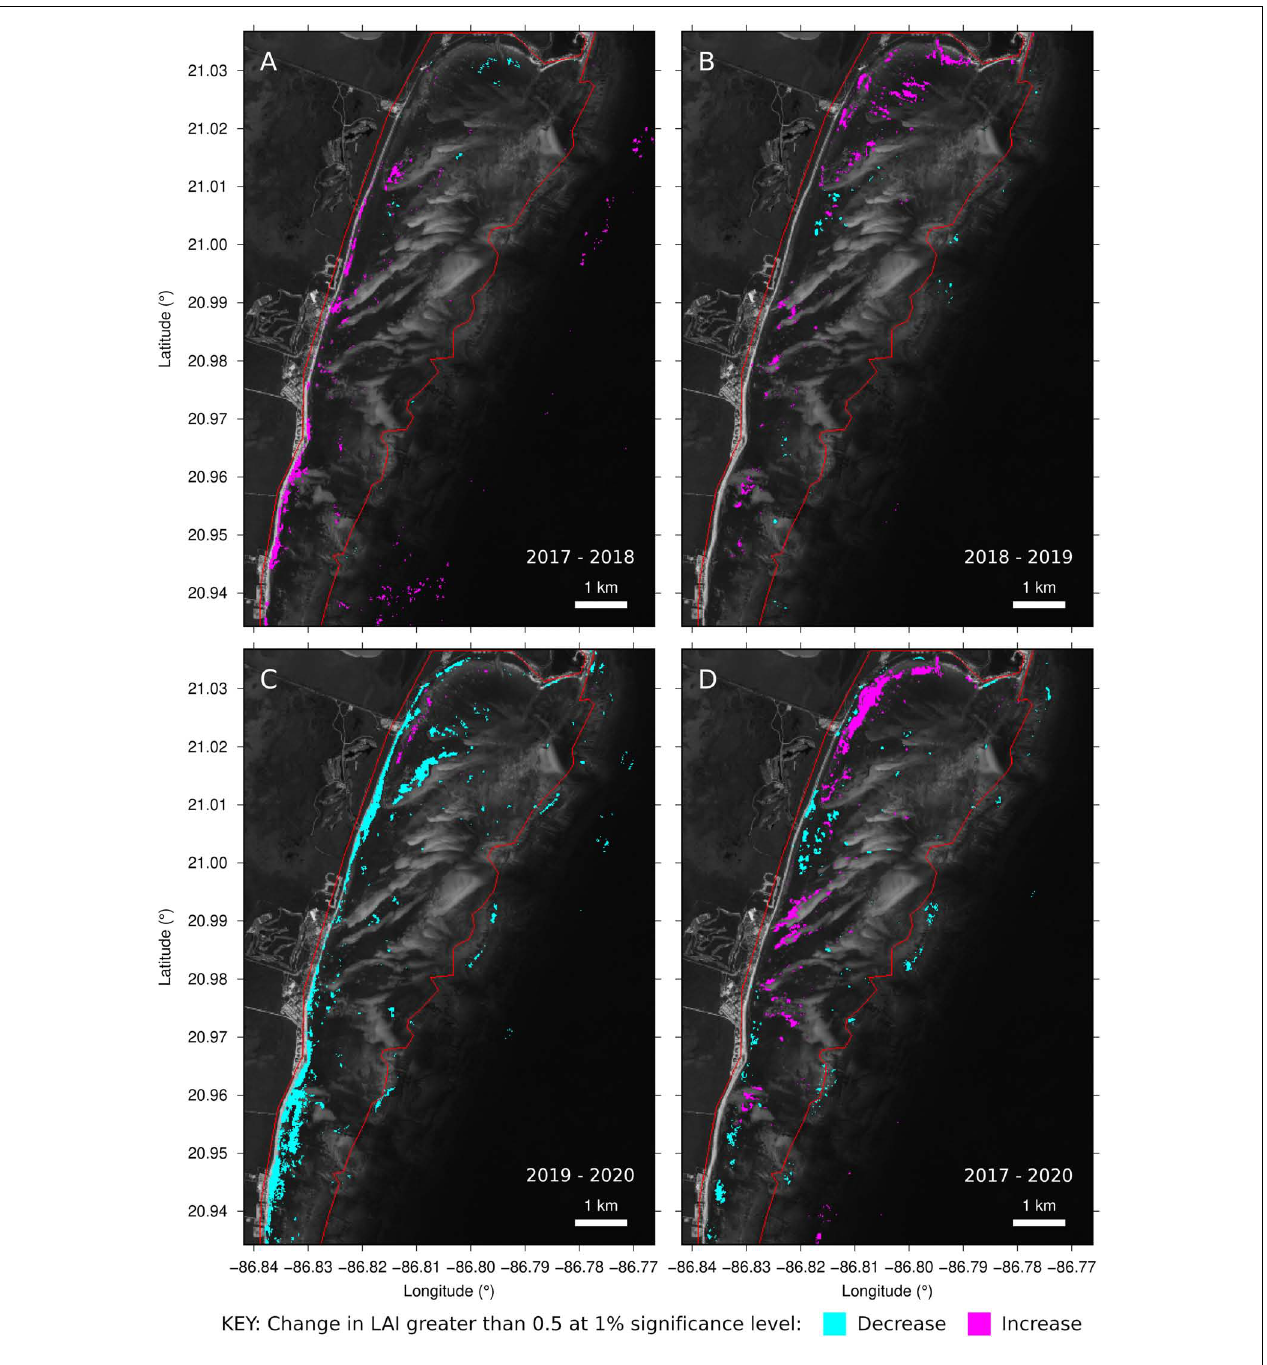
Leaf Area Index-Depth